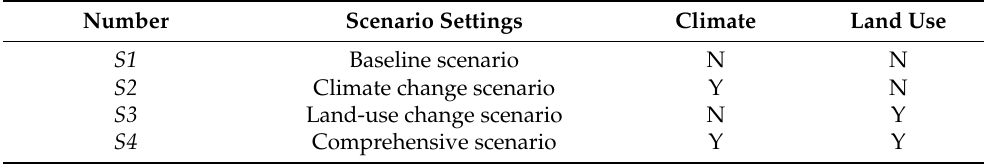
Table 6. Multifactor Attribution Scenario